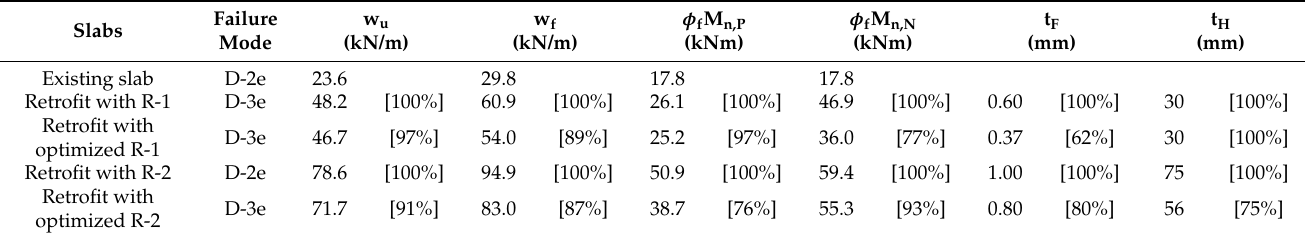
Table 7. Summary results of the strengthened slab using optimized versus non-optimized retrofit